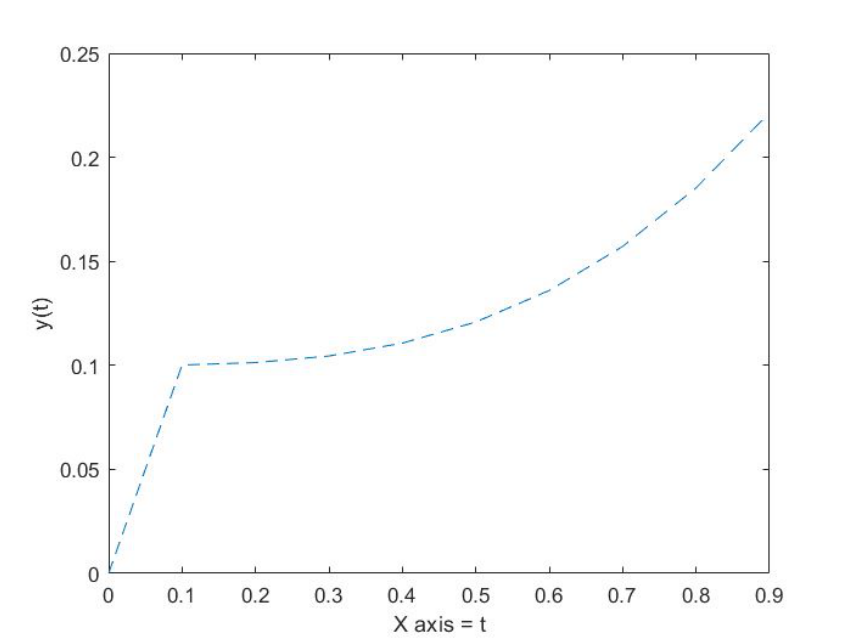
Figure 3. Graph of ι ( (cid:96) ) with an interval difference of 0.1 for Example 5.